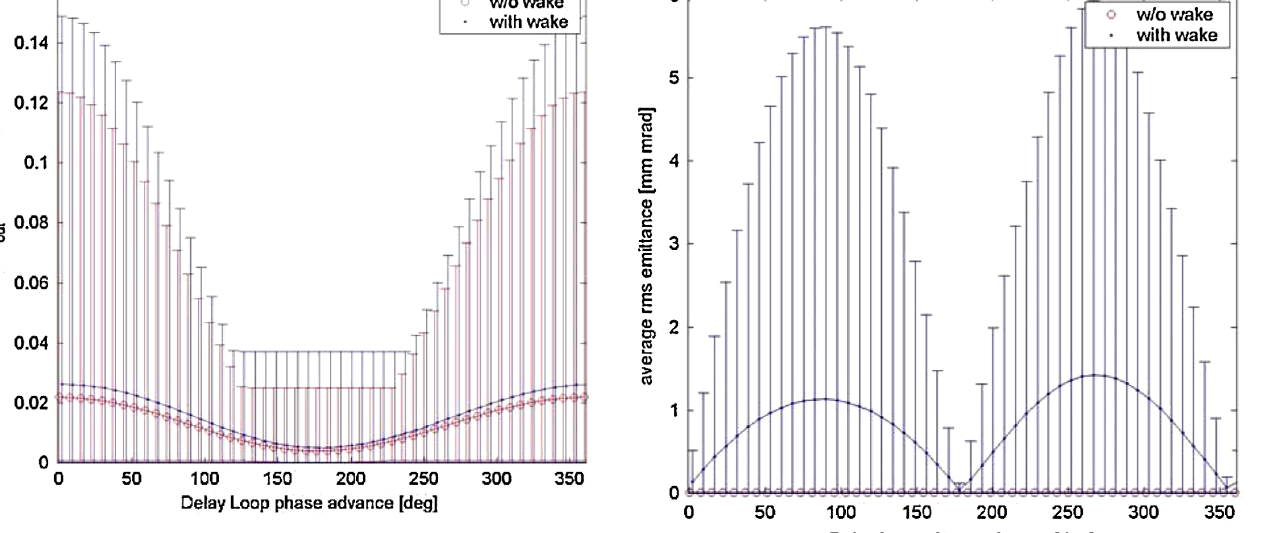
FIG. 17. (Color) Average output Courant-Snyder invariants of the bunch centroids without injection errors as a function of the DL phase advance. The bars indicate the maximum deviation from the mean value calculated over the